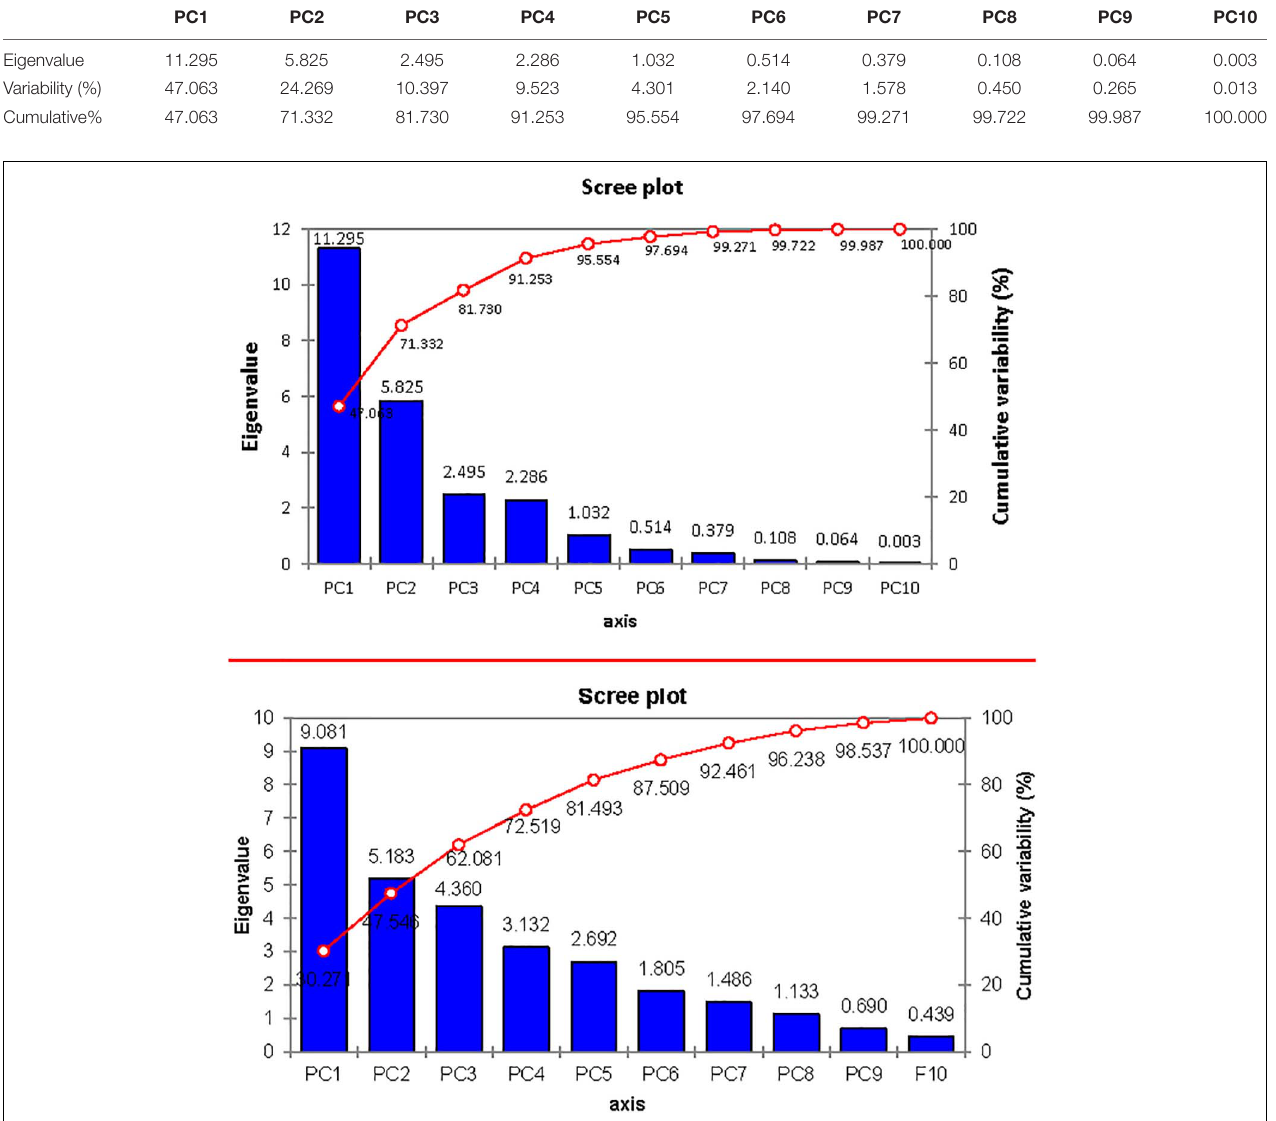
FIGURE 9 | Scree plot between eigenvalues and principal components (PCs) under control and salt stress conditions.